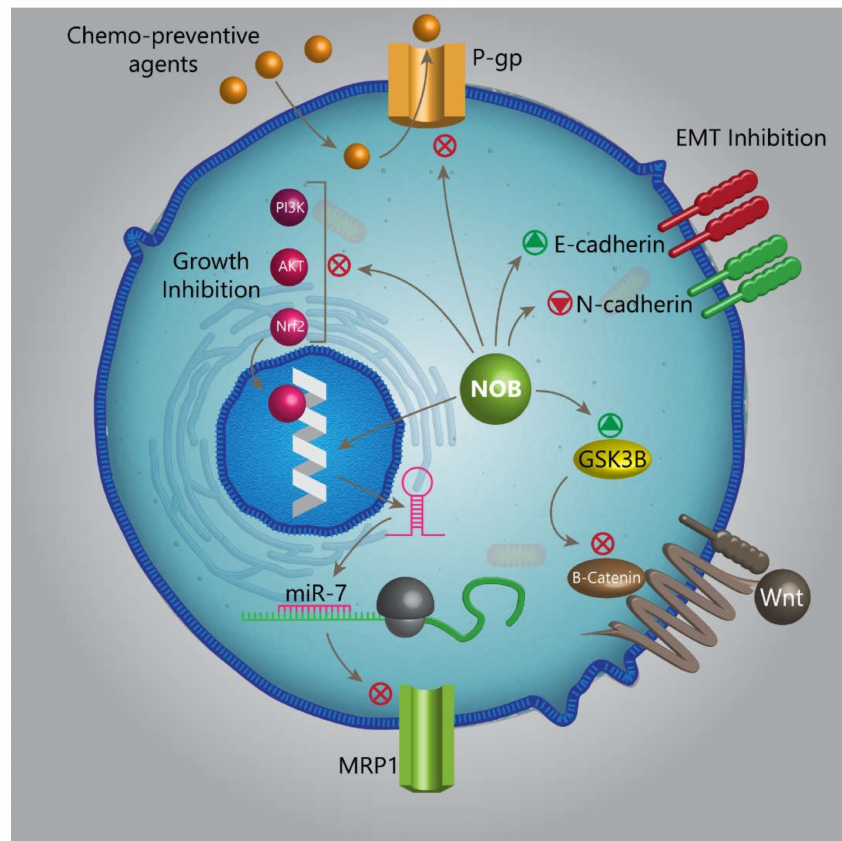
Figure 2. The capability of NOB in targeting various molecular pathways and mechanisms, making it an appropriate option in cancer therapy. P-gp, P-glycoprotein; NOB, nobiletin; miR, microRNA; MRP1, multidrug-resistance-associated protein 1; GSK-3 β , glycogen synthase kinase 3 beta; Nrf2, nuclear factor erythroid 2-related factor 2; Akt, protein kinase B; PI3K, phosphatidylinositide-3 kinase; and EMT, epithelial-to-mesenchymal